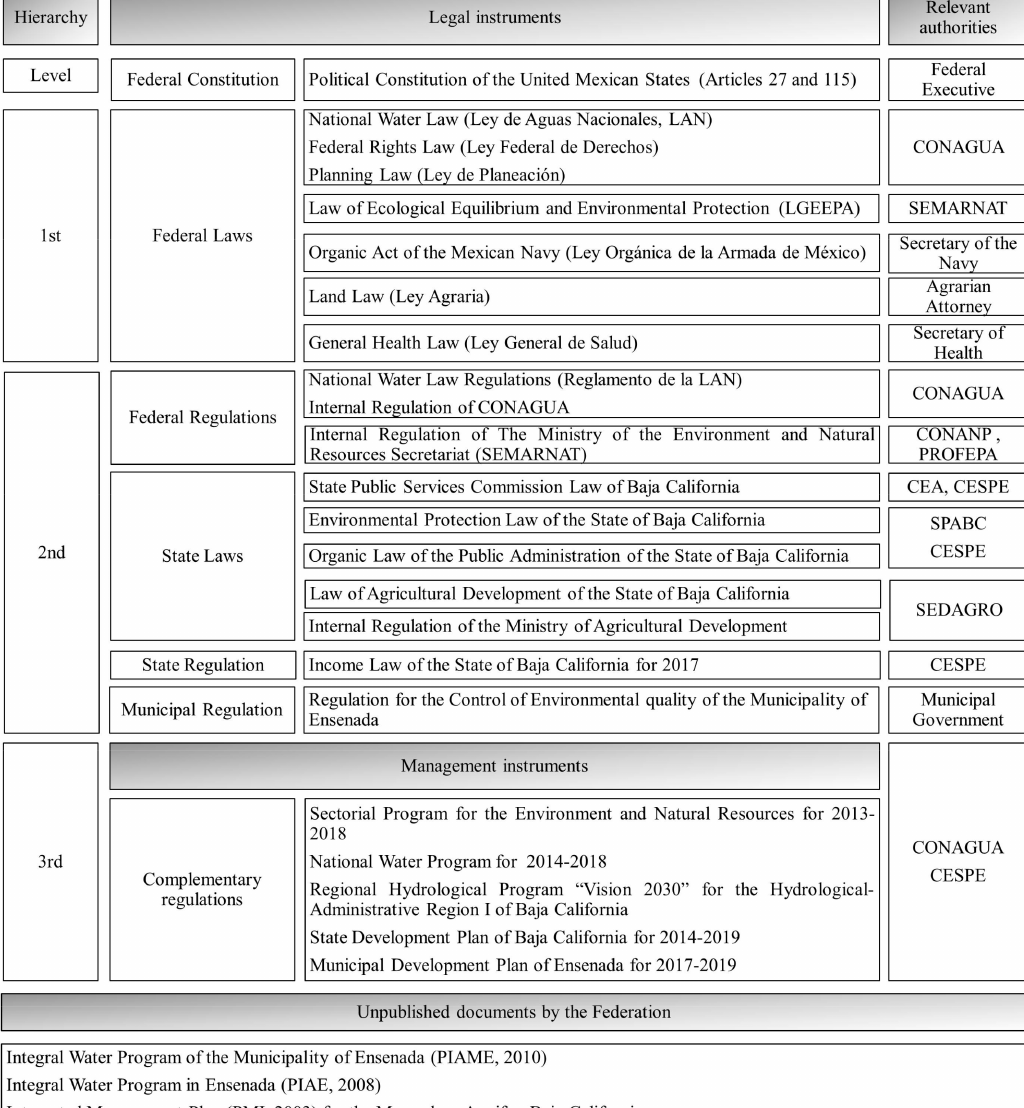
Figure 2. Hierarchical organization of the Mexican legal framework with the respective relevant institutions associated with the use of reclaimed